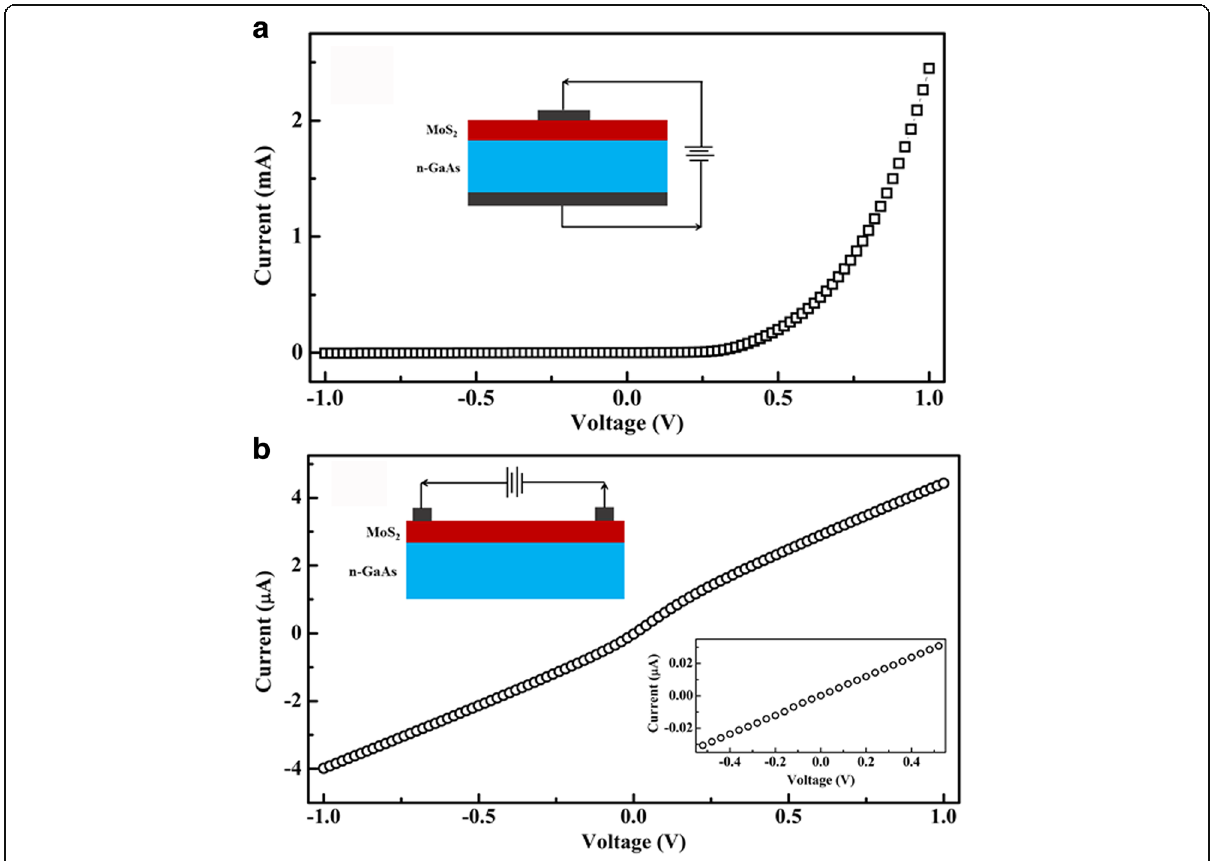
Fig. 3 a Longitudinal I - V curve of the fabricated MoS 2 / n -GaAs heterojunctions. The inset shows the schematic circuit for the longitudinal measurements. b Transverse I - V curves of the fabricated MoS 2 / n -GaAs heterojunctions. The top inset shows the schematic circuit for the transverse measurements. The bottom inset shows the I - V curves of the MoS 2 films on the intrinsic GaAs